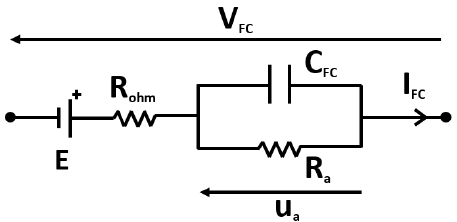
Figure 4. First-order electrical model of a fuel cell.